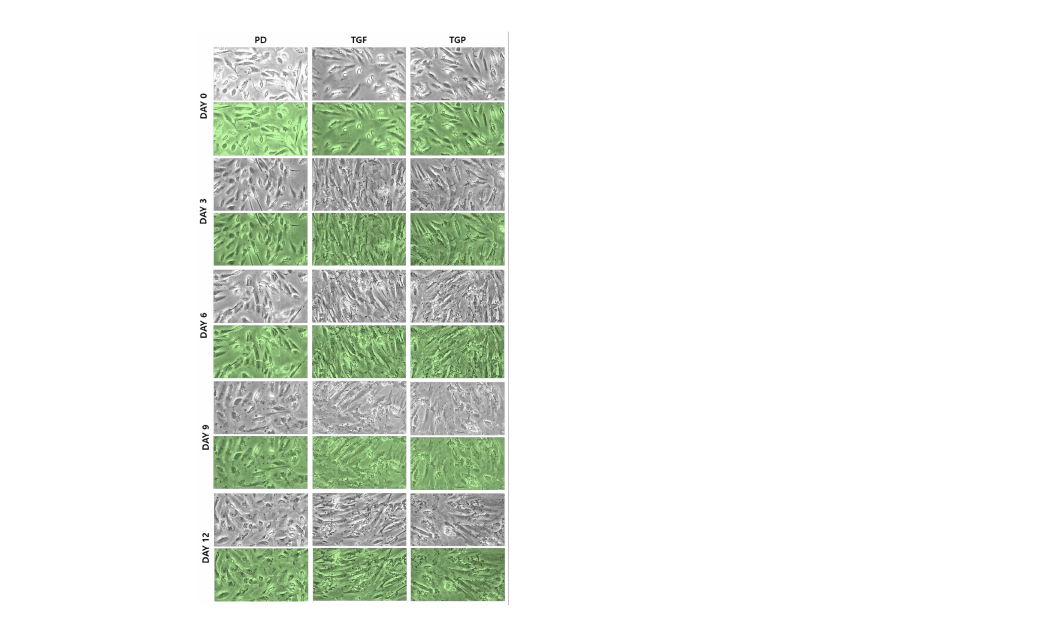
Figure 1. Morphological changes during differentiation of hUDSCs to SMCs using the indicated factors. Morphological changes observed on days 0, 3, 6, 9, and 12 during differentiation of hUDSCs into SMCs. (Magnification, 40 × ). PD: PD98059, TGF: TGF- β 1, TGP: TGF- β 1 and PD98059.